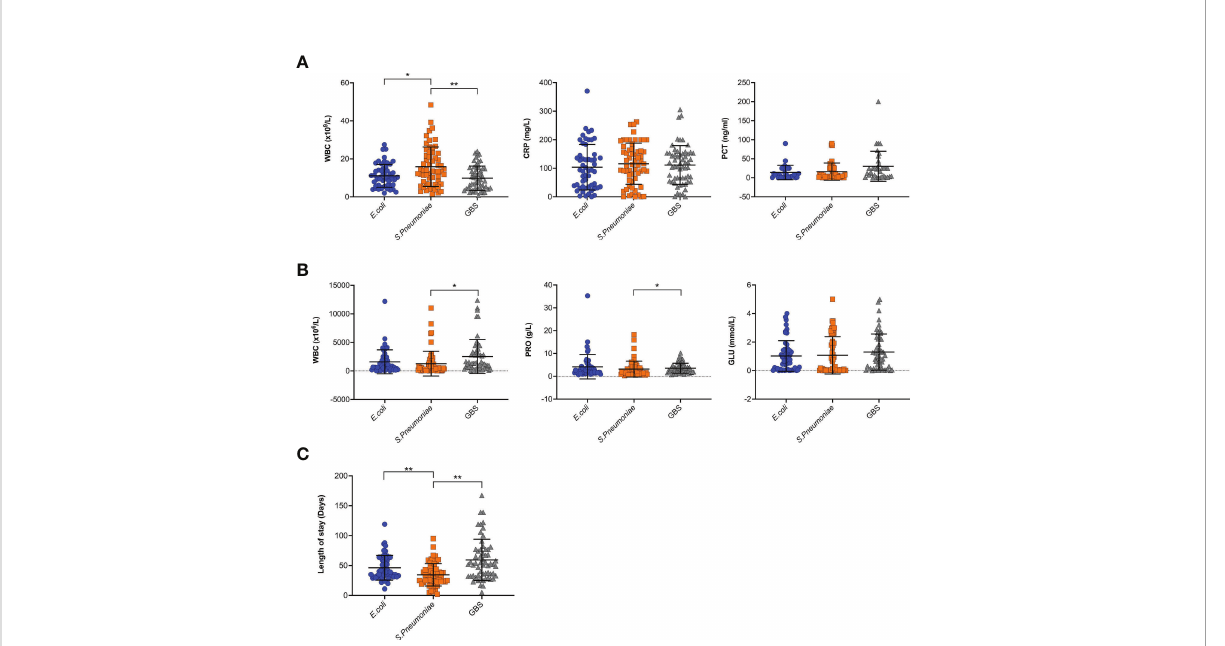
FIGURE 1 Clinical features of BM. (A) Blood samples were tested for WBC, CRP and PCT, and results were shown for each individual. (B) CSF samples were tested for WBC, PRO, and GLU, and results were shown for each individual. (C) The length of stay in hospital for each patient were shown. (* p <0.05; ** p